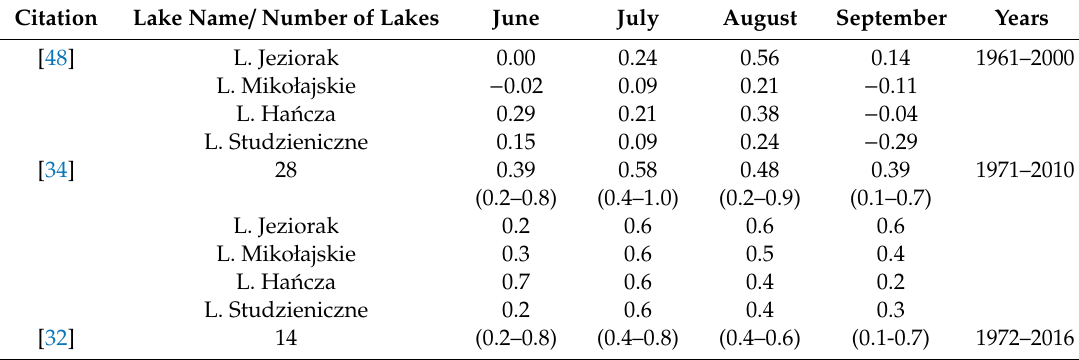
Table 2. Lake surface water temperature (LSWT) trends of northern Poland lakes. Presented trends are the average (sometimes range) in ◦ C decade − 1